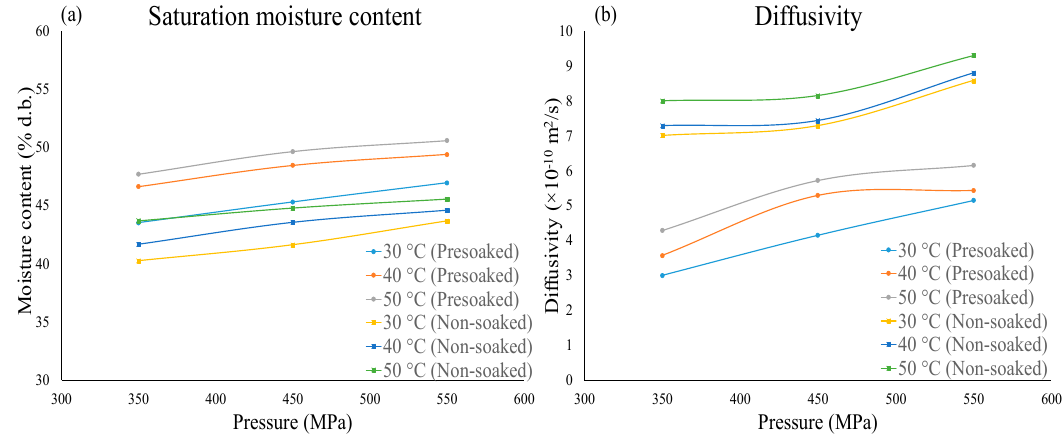
Figure 9. ( a ) Water uptake and ( b ) water diffusivity in presoaked and nonsoaked paddy grains subjected to HPP (plotted using the data from Ravichandran, Purohit and Rao, 2018 [50]).